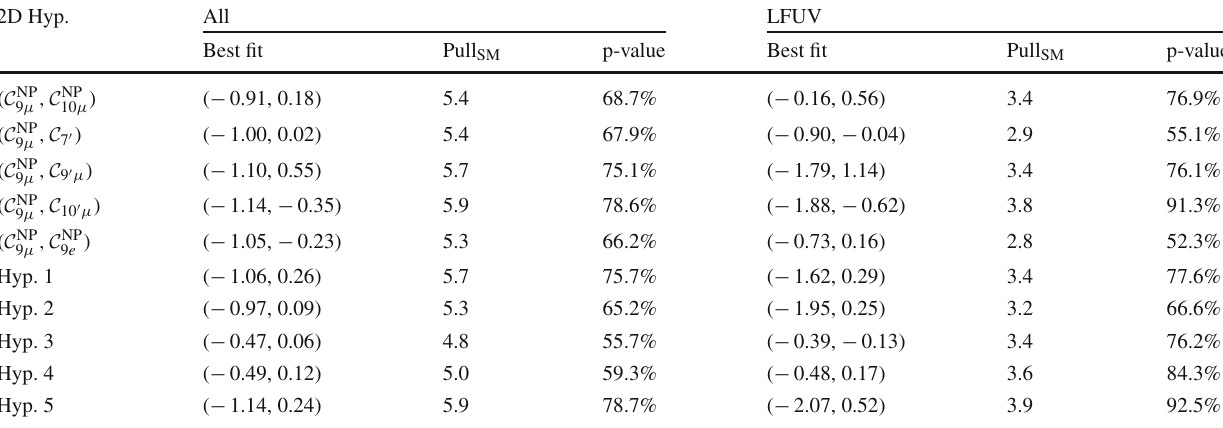
Table 2 Most prominent 2D patterns of NP in b → s μ + μ − . The last five rows correspond to Hypothesis 1: ( C NP = − C , C NP = − C ) , 3: ( C NP = − C NP , C = C ( C NP 9 (cid:4) μ 10 (cid:4) μ 9 (cid:4) μ 10 (cid:4) μ ), 4: 9 μ 10 μ 9 μ 10 μ